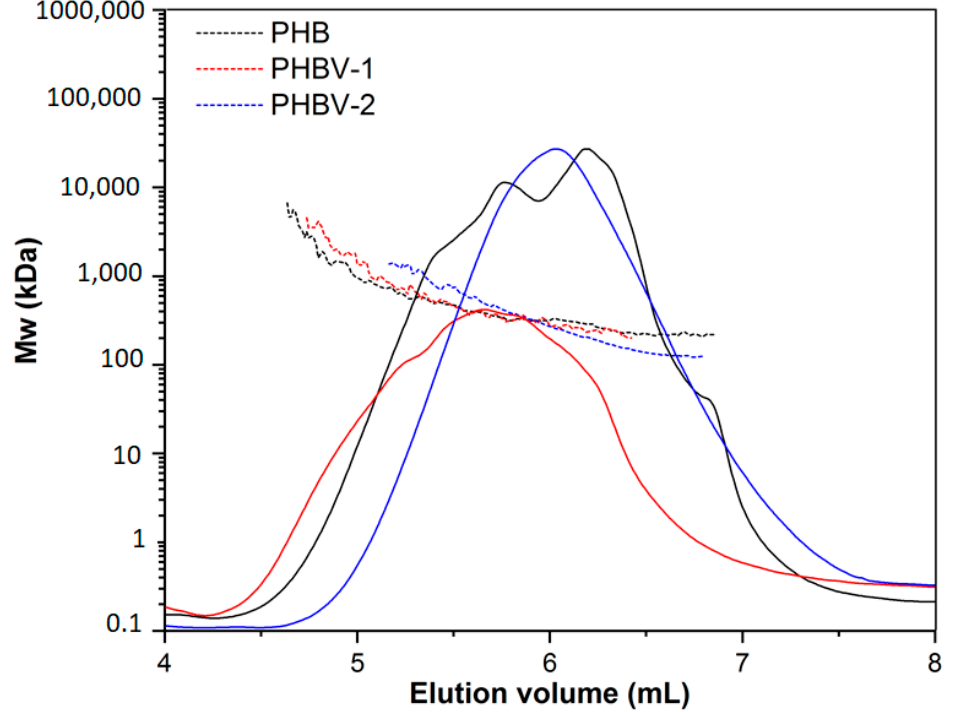
Figure 3. Size exclusion chromatography-multiangle laser light scattering (SEC-MALLS) chromatograms of PHB, PHBV-1, and PHBV-2.